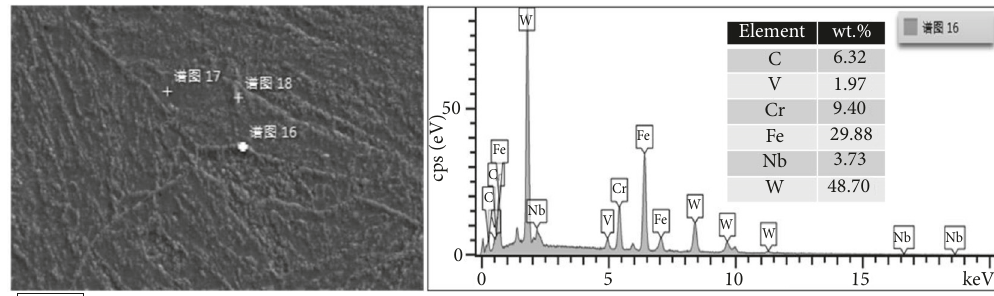
Figure 5: BSE image of G115 steel after aging at 650 ° C for 500h and its EDS